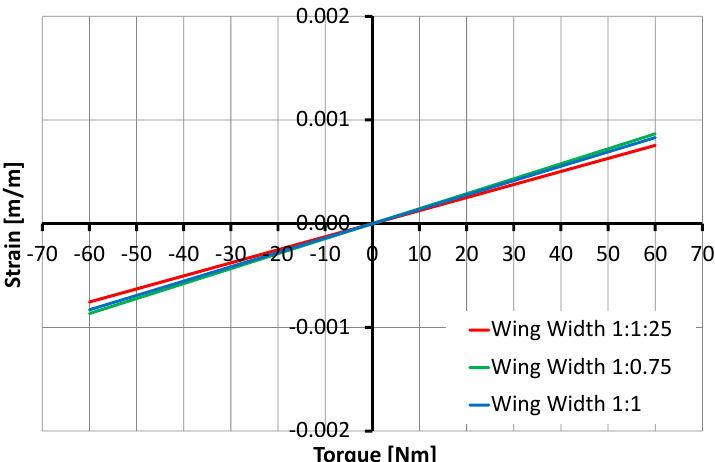
Figure 13. Relationship between torque and the strain depending on the wing width showing that 25% variation of width has negligible effects.